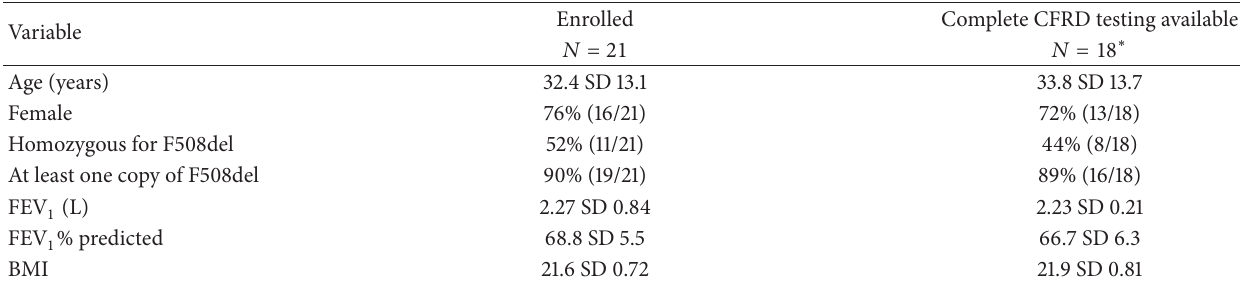
Table 1: Subject demographics at enrollment.